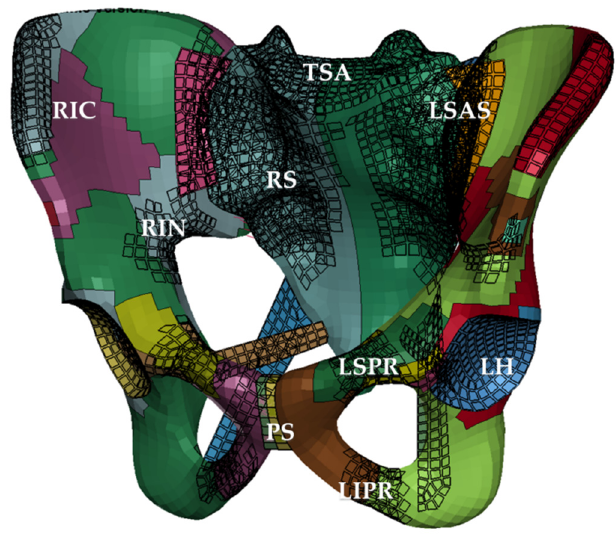
Figure 6. Interesting sites of the pelvis to extract the biomechanical variables (black meshes represent the target elements).